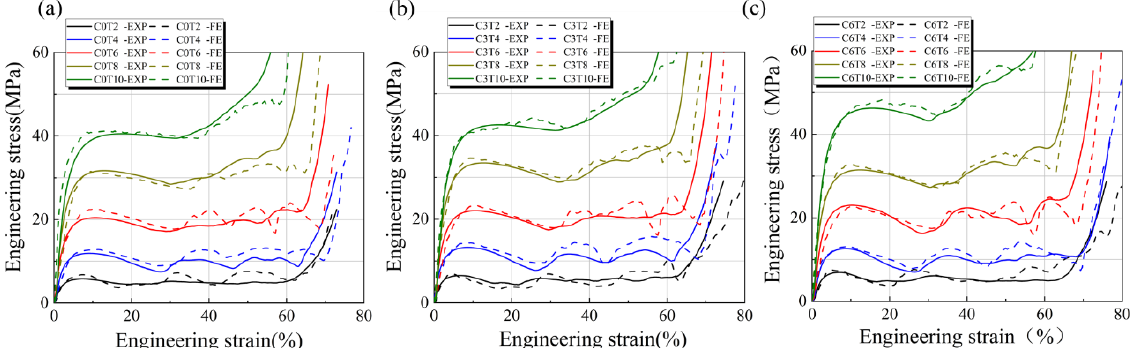
Figure 10. The strain – stress curve of P-TPMS structures in experiment and FE simulation. ( a ) Shows as-built samples with C values of 0 and different thickness of 0.2, 0.4, 0.6, 0.8 and 1.0mm. ( b ) Shows as-built samples with C values of 0.3 and different thickness of 0.2, 0.4, 0.6, 0.8 and 1.0mm. ( c ) Shows as-built samples with C values of 0.6 and different thickness of 0.2, 0.4, 0.6, 0.8 and 1.0mm.